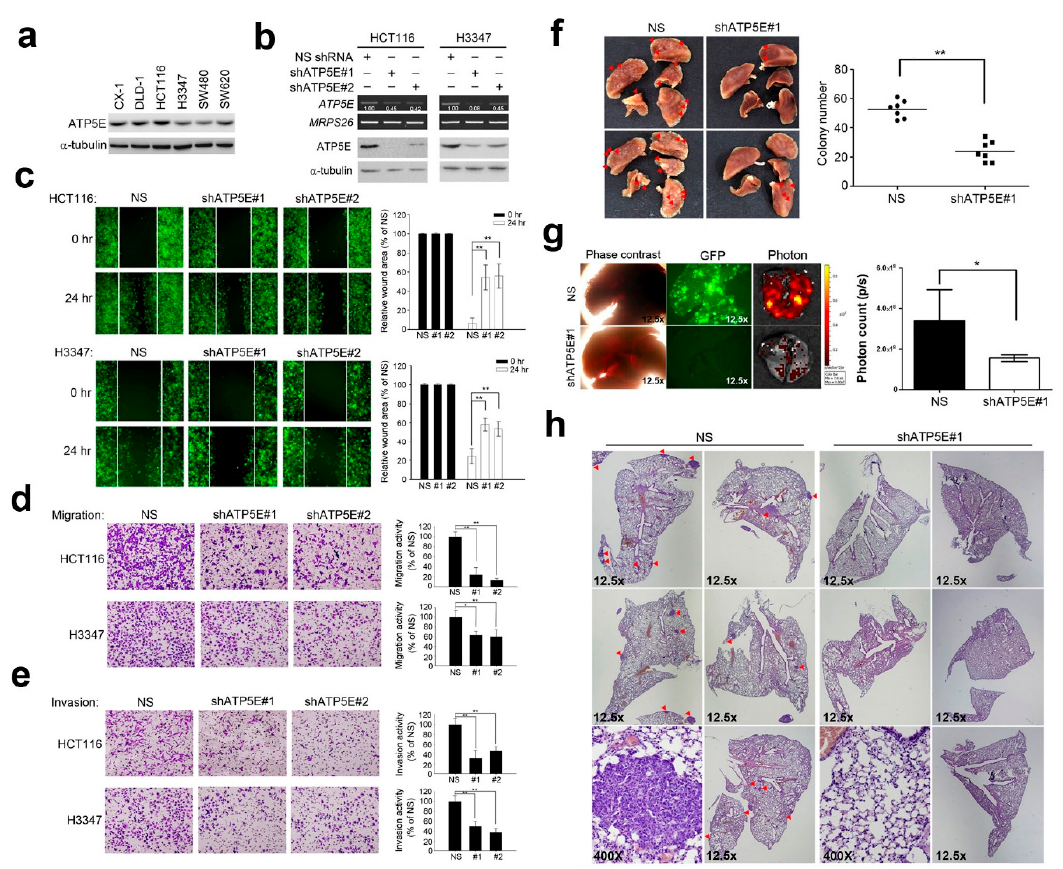
Figure 2. ATP synthase epsilon subunit (ATP5E) silencing inhibited invasion and migration in vitro and distal metastasis in vivo. ( a ) Endogenous ATP5E protein expression in six colorectal cancer cell lines. ( b ) Knockdown of ATP5E expression in HCT116 and H3347 cells by ATP5E shRNAs. The knockdown efficiency was determined by an RT-PCR and Western blot analyses. ( c ) Wound-healing assay carried out on HCT116 and H3347 cells. Relative wounded areas were compared between the non-silencing (NS) control and shATP5E cells at 24 h. ( d ) Migration assay for the NS control and shATP5E cells of the HCT116 and H3347 cell lines using Boyden chambers. ( e ) Invasion assay for the NS control and shATP5E cells of the HCT116 and H3347 cell lines using Boyden chambers pre-coated with Matrigel shown in the lower panel. ( f ) Representative lung images of mice injected with the NS control and shATP5E cells are shown in the left panel. Total numbers of lung metastatic nodules in individual mice 2.5 weeks after a tail vein injection of HCT116 NS control or shATP5E cells are shown in the right panel. ( g ) Green fluorescence and photon images of the lungs of mice injected with HCT116 NS control or shATP5E cells. The color bar represents the fluorescence intensity. ( h ) Representative H&E staining of lung sections at 12.5× and 400×. Red arrows indicate metastatic nodules.